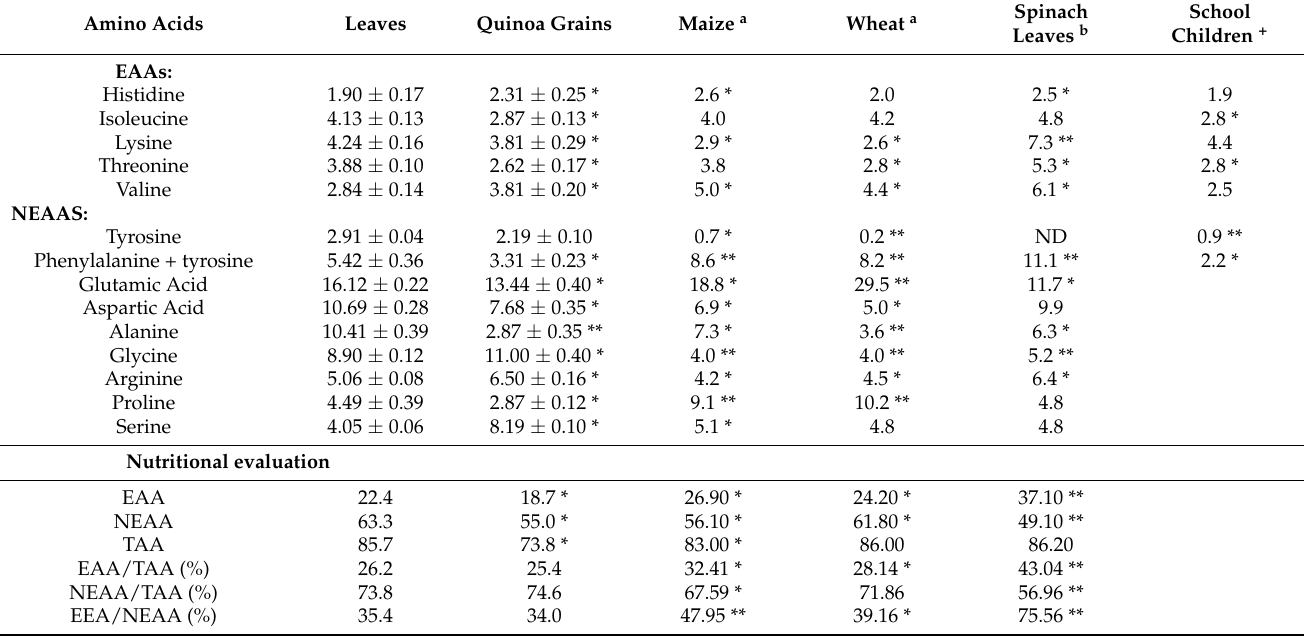
Table 2. Comparison of amino acid profiles of quinoa leaves with quinoa grains and other plants (g/100 g protein dry weight of the